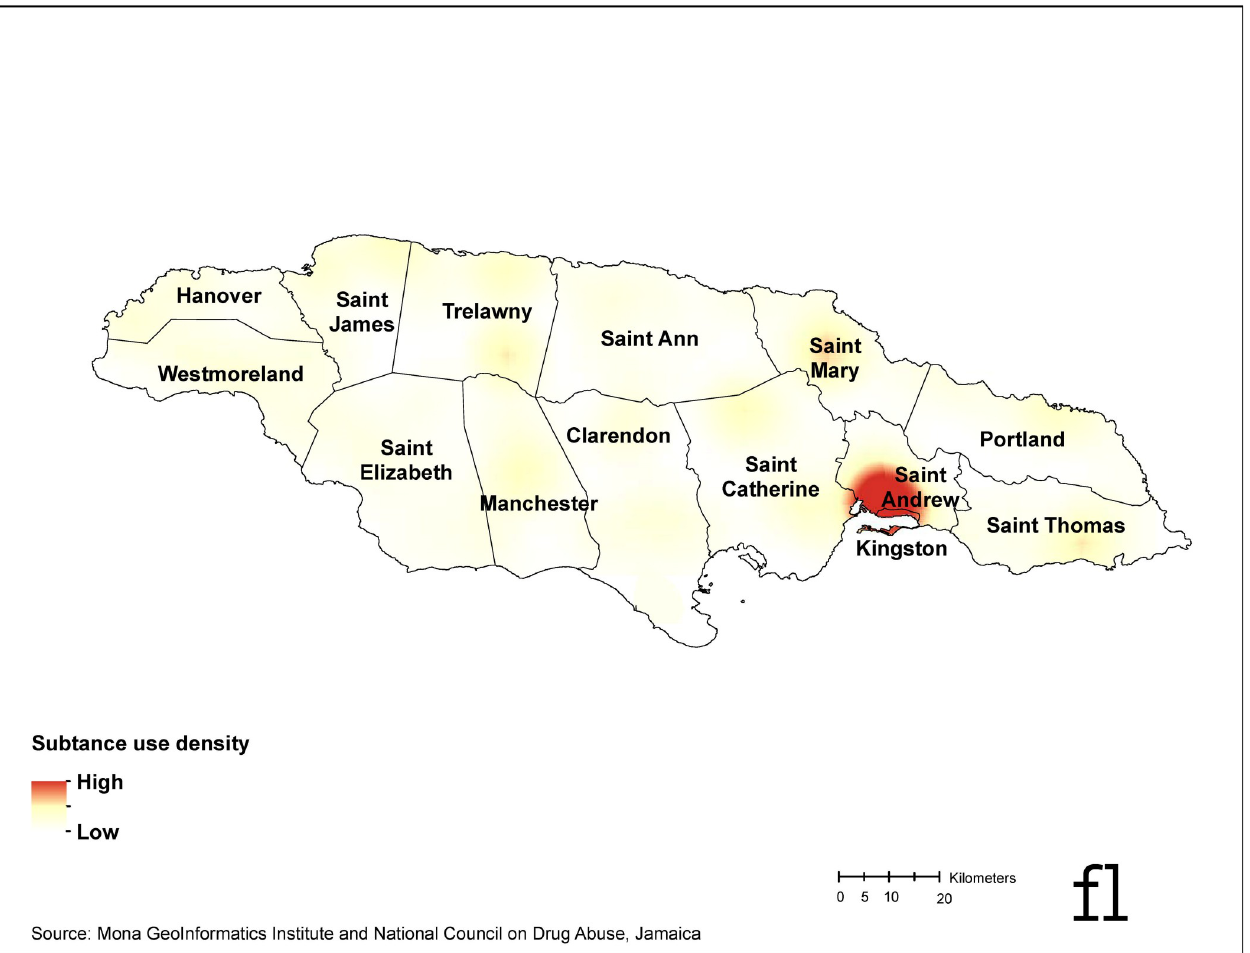
Fig 2. Current substance use density map, Jamaica 2016. Geographic data source: Mona GIS, Jamaica. Published under a CC BY license, with permission from Mona GeoInformatics Institute, original copyright 2019.